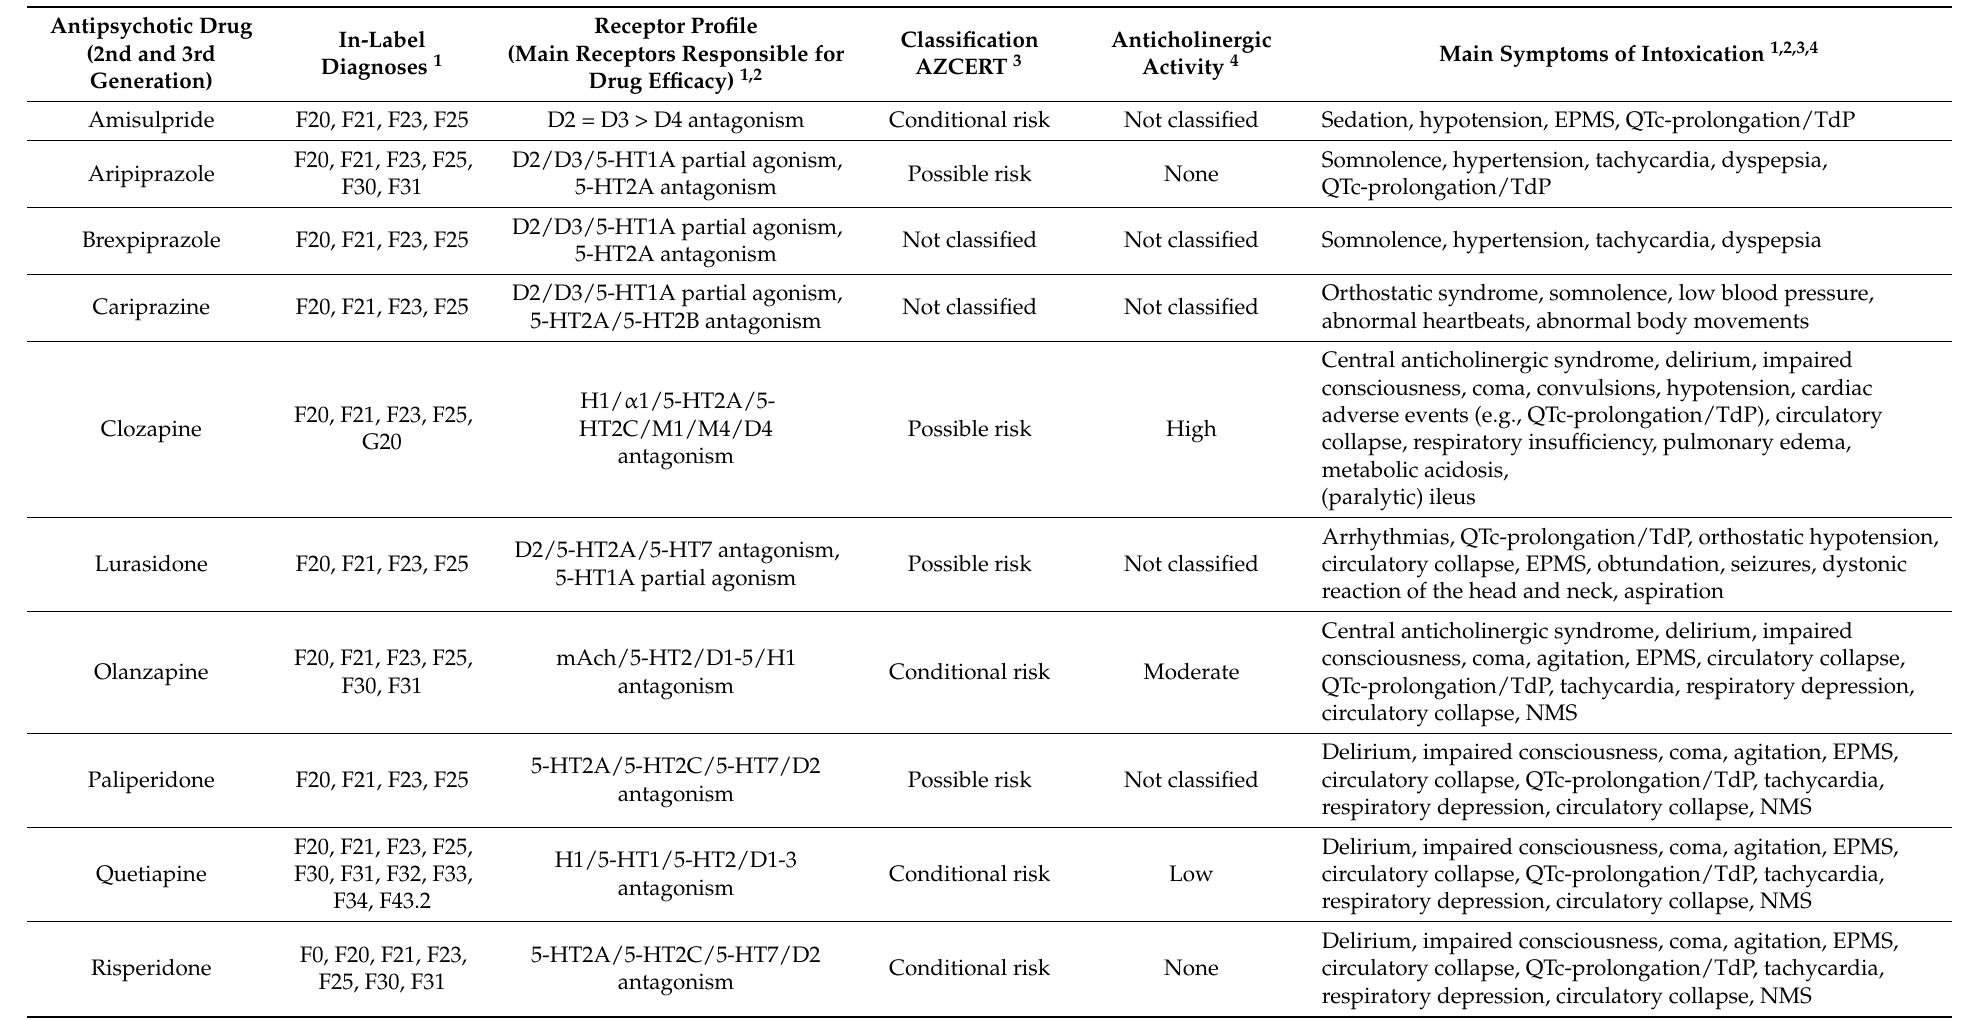
Table 2. Pharmacodynamic characteristics of second- and third-generation antipsychotic